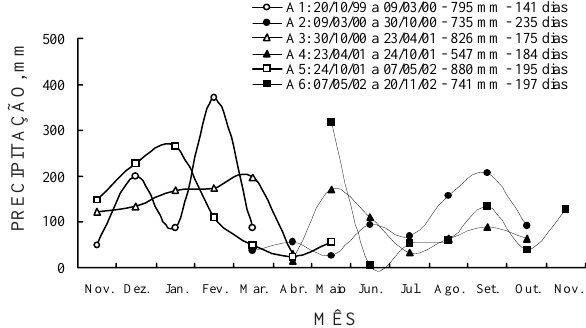
Figura 1. Precipitações pluviais mensais no período do experimento de 20/10/1999 a 20/10/2002, obtidas da Estação Agrometeorológica de Paranavaí, localizada na Estação Experimental do Instituto Agronômico do Paraná (IAPAR), distante 15 Km da área experimental. A1 a A6 correspondem ao somatório das precipitações e do número de dias que antecederam cada uma das seis amostragens de solo.